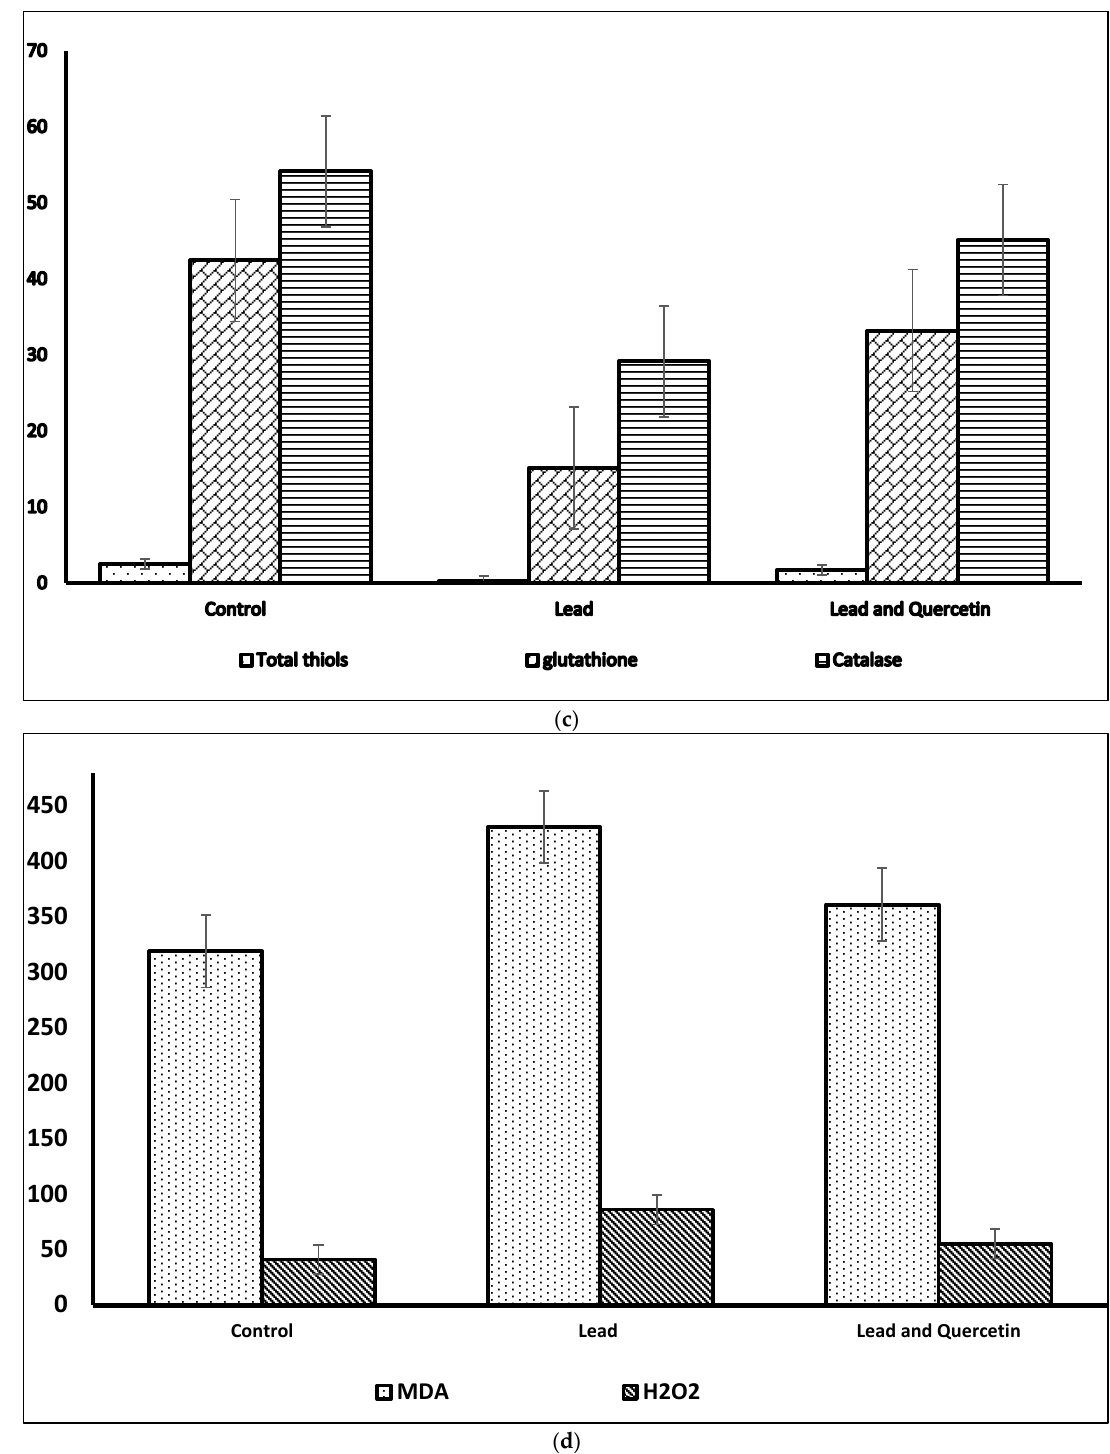
Figure 2. Biochemical parameters in rats exposed to lead, and rats exposed to lead and given quercetin phytosome, compared with the untreated control rats. ( a ) Levels of total proteins (g/dL), albumin (g/dL), globulin (g/dL), creatinine (mg/dL), BUN (mg/dL) and bilirubin(mg/dL). ( b ) Levels of alanine transferase (ALT) (IU/L), aspartate transferase (AST) (IU/L) alkaline phosphatase (ALP) (IU/L) and urea (mg/dL). ( c ) Levels of total thiols (mmol/L), glutathione ( µ g/mL) and catalase (IU/L). ( d ) Levels of malondialdehyde (MDA) (nmol/mL) and hydrogen peroxide (H 2 O 2 )